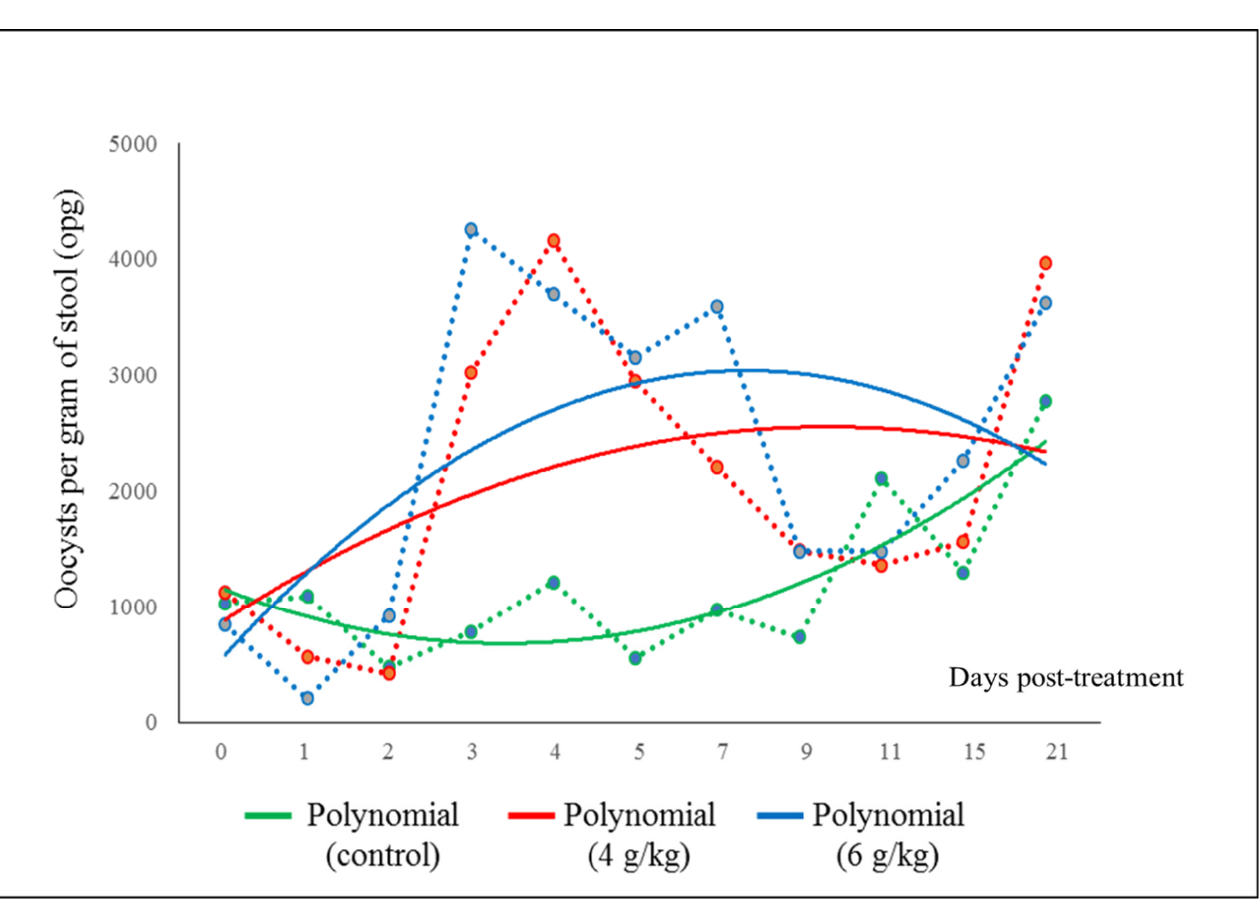
Table 3. Productive performance (means ± SD, in g) of Pelibuey lambs with different doses of Hura crepitans seeds.